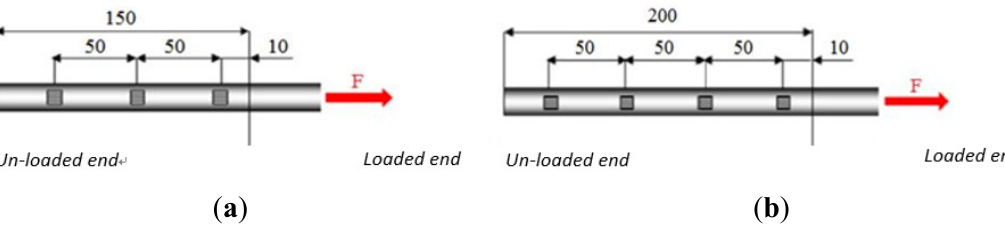
Figure 10. Strain gauge arrangement on FRP bar: ( a ) for a bonded length of 150 mm; ( b ) for a bonded length of 200 mm.